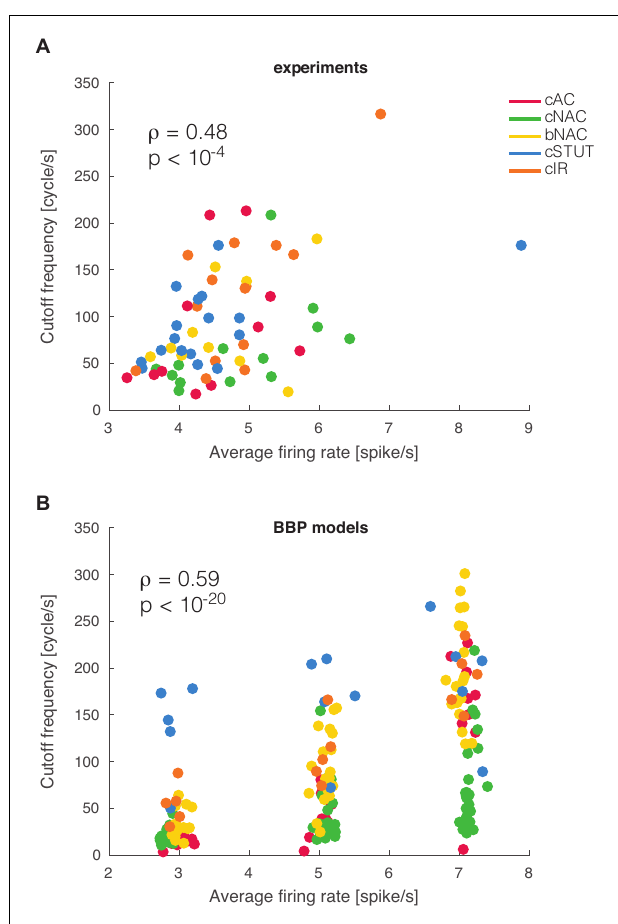
FIGURE 4 | Mean firing rate modulation of the cut off frequencies. As suggested by earlier theoretical studies, a significant correlation was observed between the mean firing rate of a cell and the cut off frequency of its dynamical transfer function (A) . The very same result was reproduced in silico for the BBP models (B)